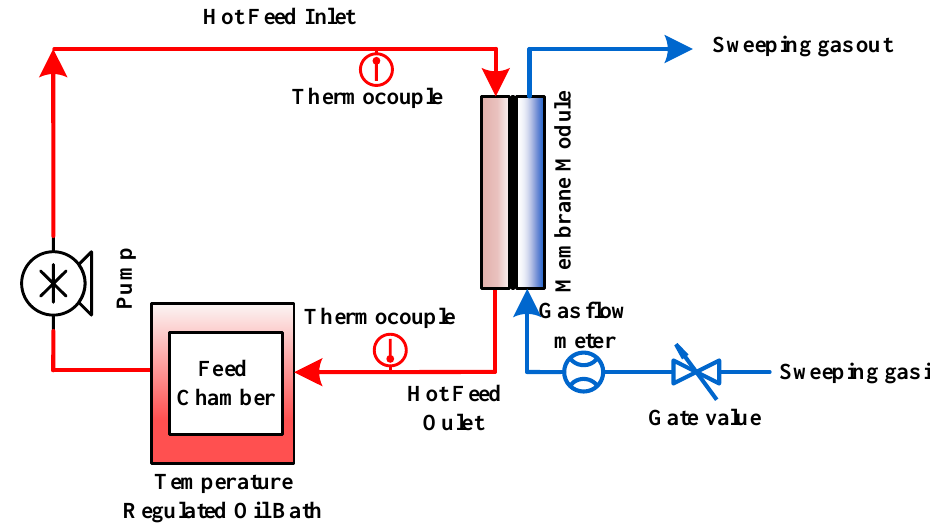
Figure 1. Schematic diagram of the experimental setup for the sweep gas membrane distillation (SGMD).